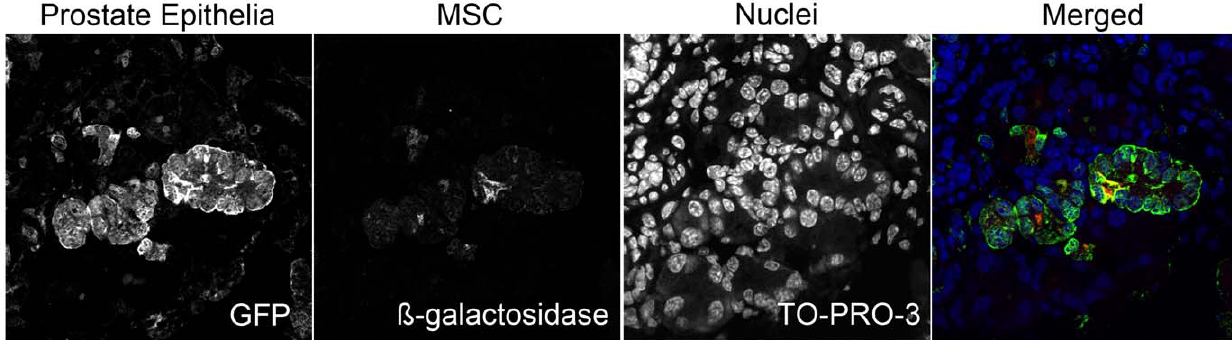
Figure 5. MSCs fused to the prostate during regrowth. b -galactosidase-expressing MSCs were injected into castrated GFP mice supplemented with exogenous testosterone for three days. Confocal microscopy showed colocalization of b -galactosidase-expressing MSCs (red) with GFP prostate ducts (green). Nuclei were stained with TO-PRO-3 (blue). Merged color panel illustrates colocalization of MSCs (red) with prostate epithelia (green), indicated by yellow. Fusion occurred in 48.9% of recruited